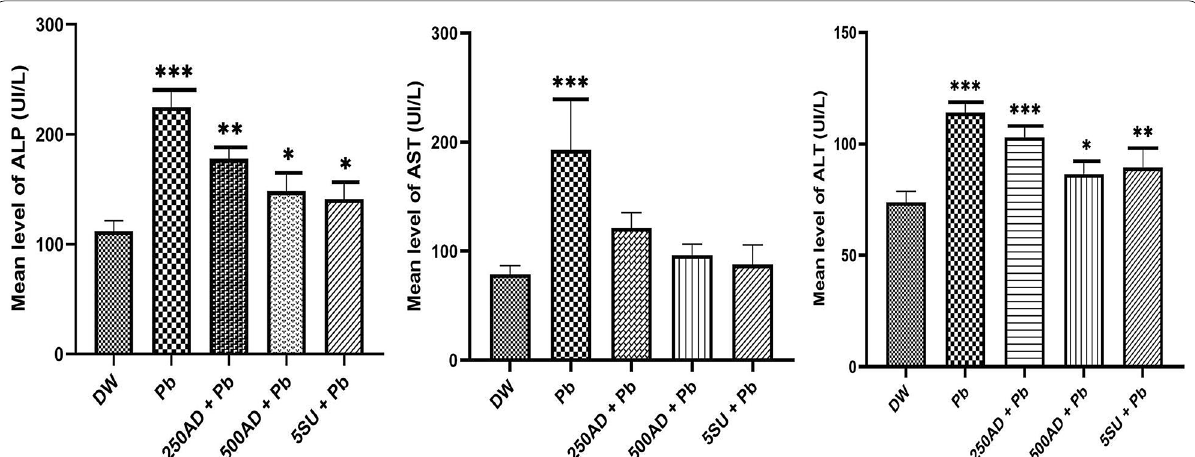
Fig. 1 Bar chats of the liver enzymes parameters (ALP, AST and ALT) after 6 weeks of the experiment. Data were analysed using one way ANOVA, followed with Tukey post hoc test, * p < 0.033; ** p < 0.002; *** p < 0.0001 for the experimental treated groups when compared with the control Group (DW). Data are mean SEM, n 5 rats for each ± =